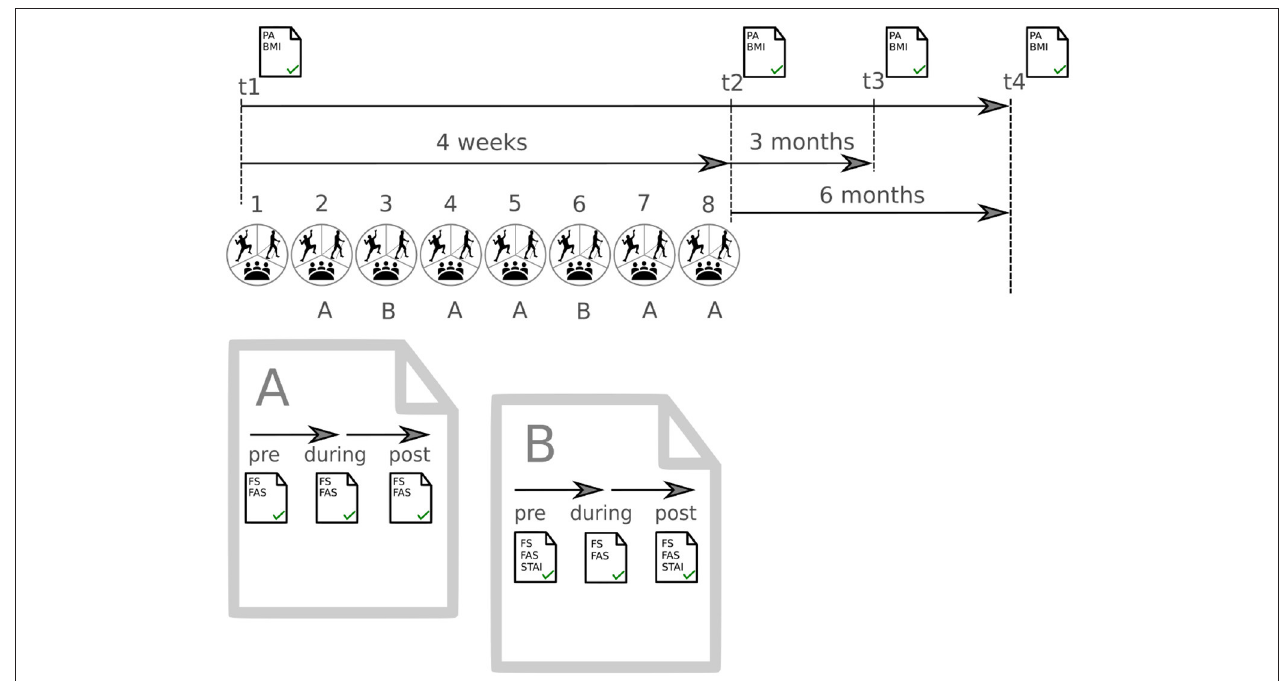
FIGURE 1 | Schedule of the complete project. Measurement of physical activity (PA) and Body Mass Index (BMI) at 4 timepoints (t1–t4). Procedure of measurement for affective responses from session 2–8. Set A Feeling Scale (FS) and Felt Arousal Scale (FAS) were recorded in all sessions. Set B was recorded in sessions 3 and 6 and additionally included the State-Trait-Anxiety Inventory